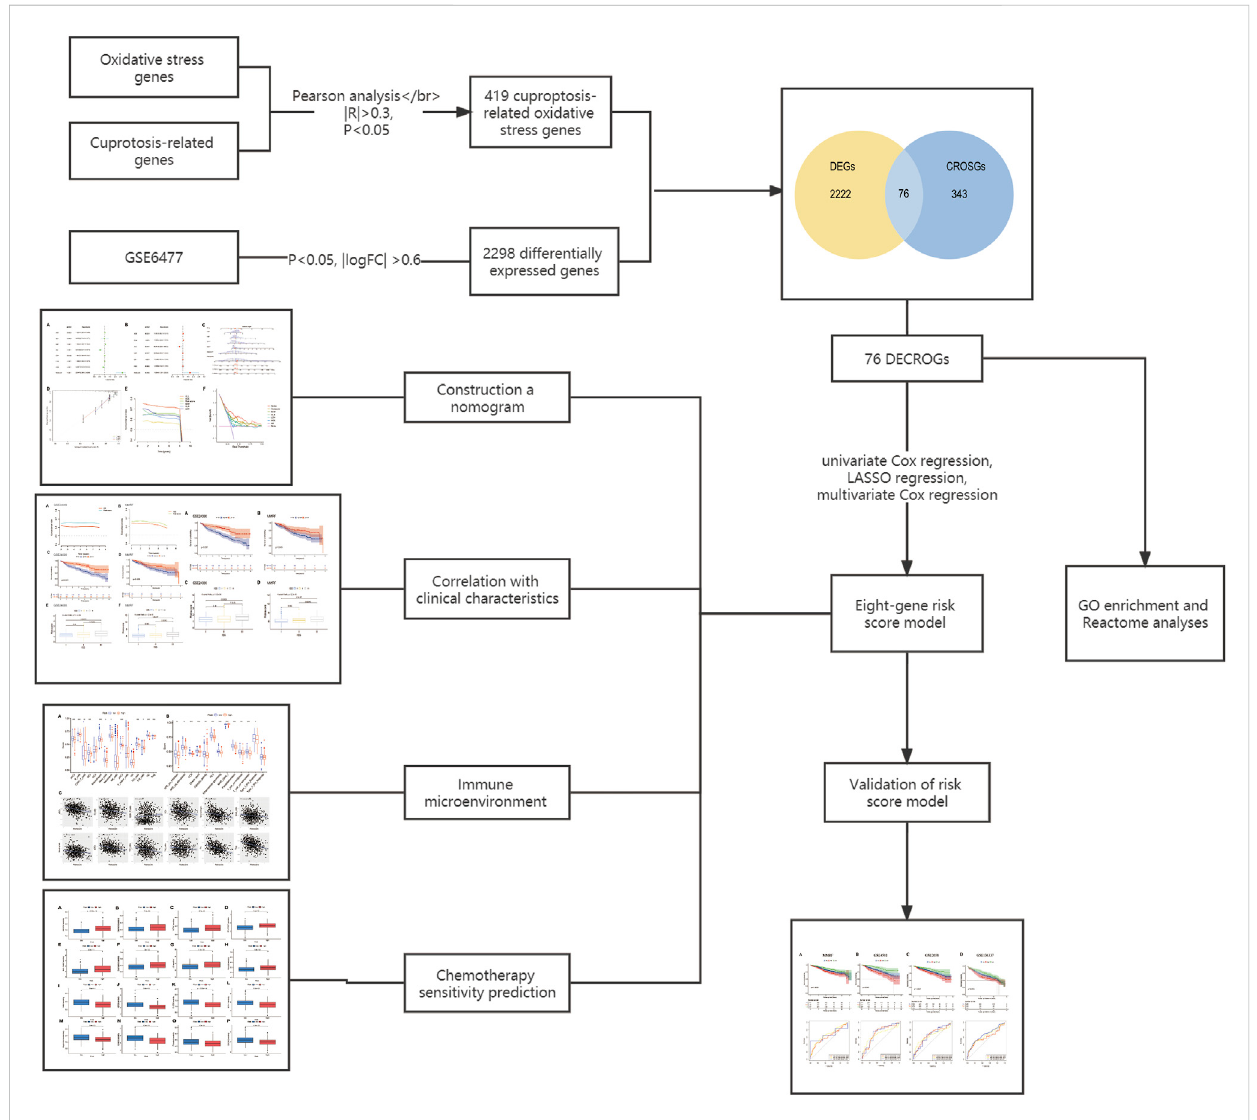
FIGURE 1 Flow chart of this